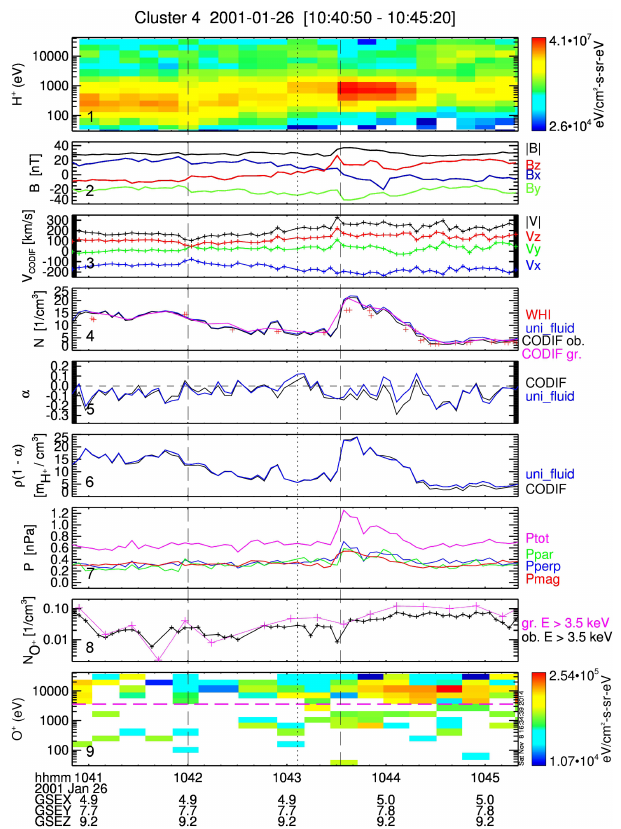
Figure 7. Plasma and magnetic field parameters for the inbound transition from 26 January 2001 as measured by Cluster 4 satellite. The layout is the same as in Fig. 2.